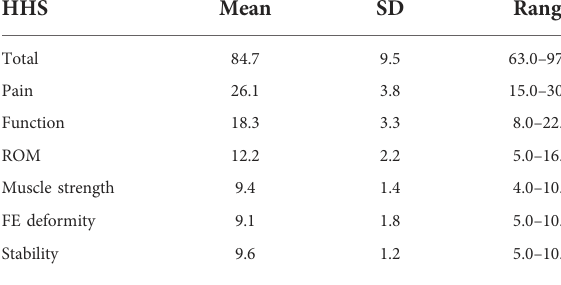
TABLE 2 HSS scores of all patients.